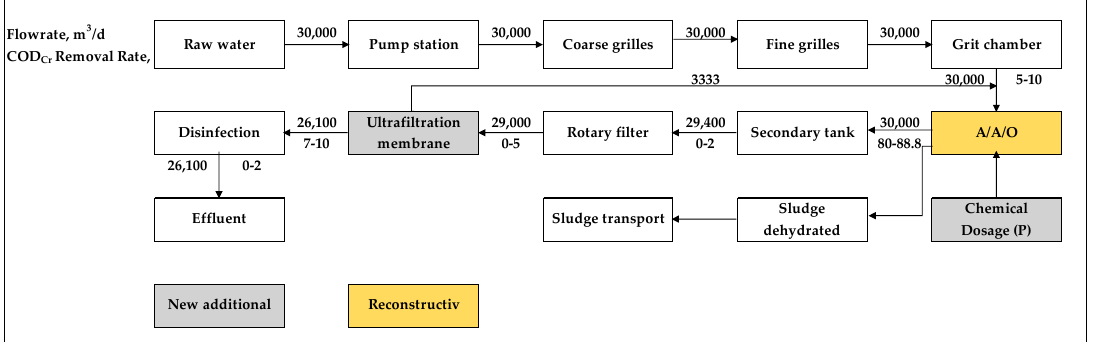
Figure 2. Treatment process of the plant before renovation.